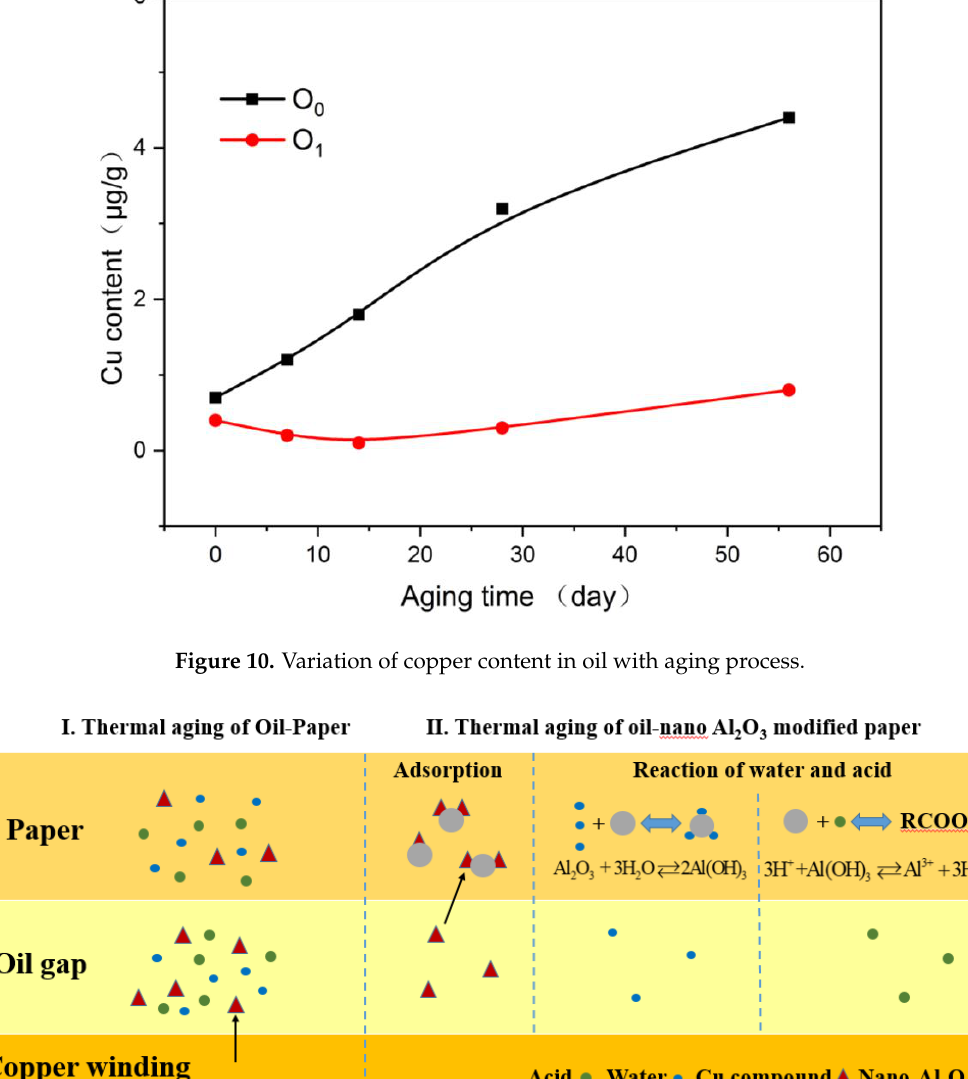
Figure 10. Variation of copper content in oil with aging process.